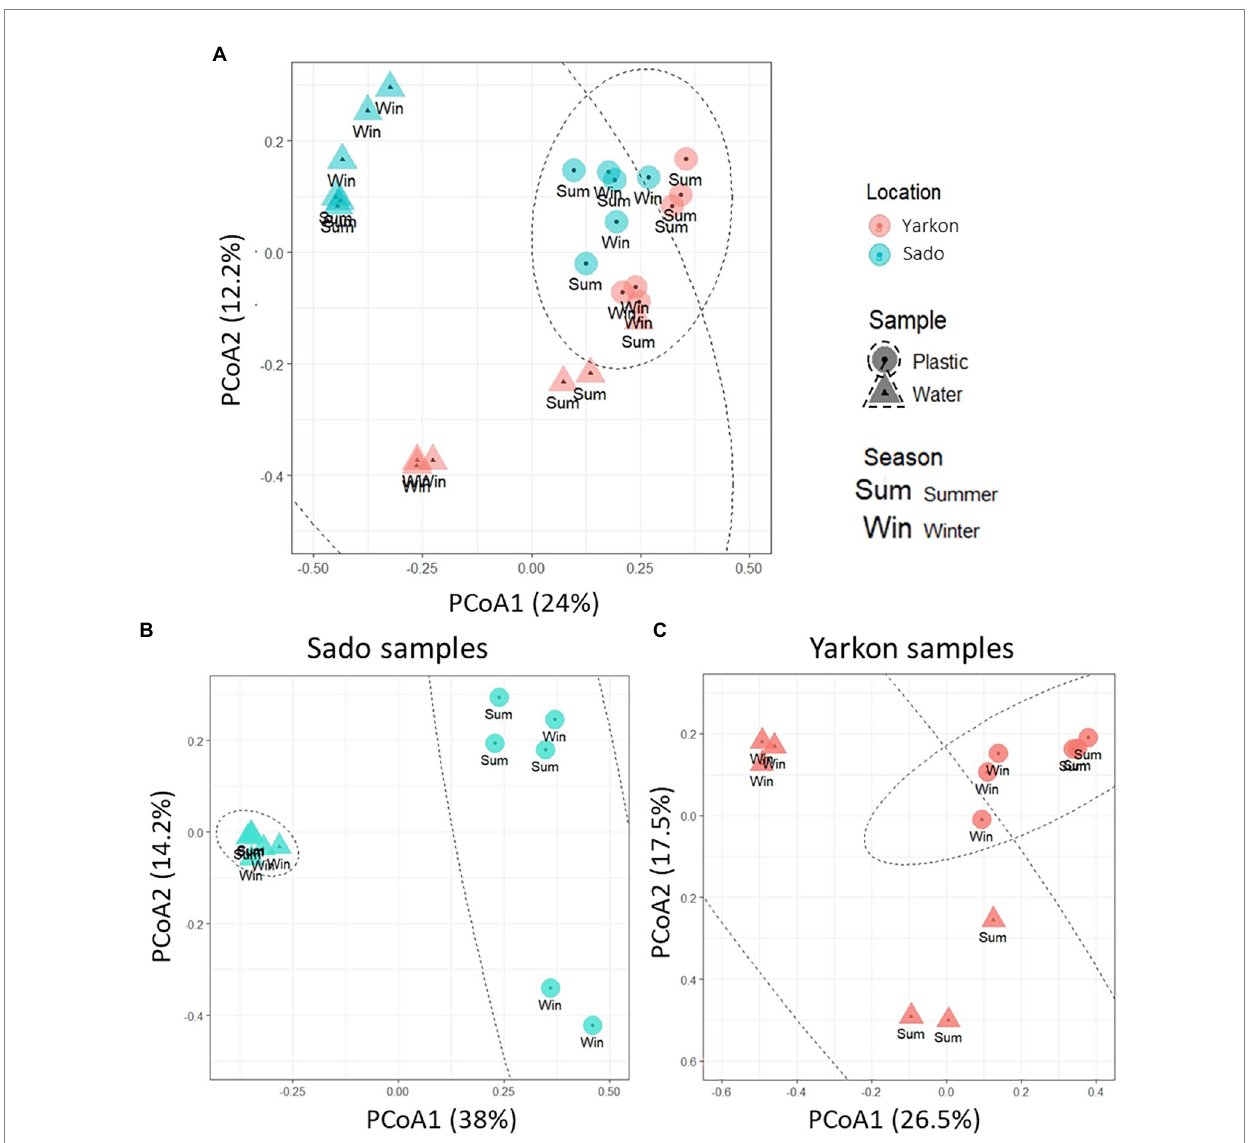
FIGURE 4 PCoA plot of the Bray-Curtis dissimilarities among the 16S-based microbiomes of the samples (Beta diversity, N = 3 per treatment). (A) Diversity among all samples. (B) Diversity among Sado samples. (C) Diversity among Yarkon